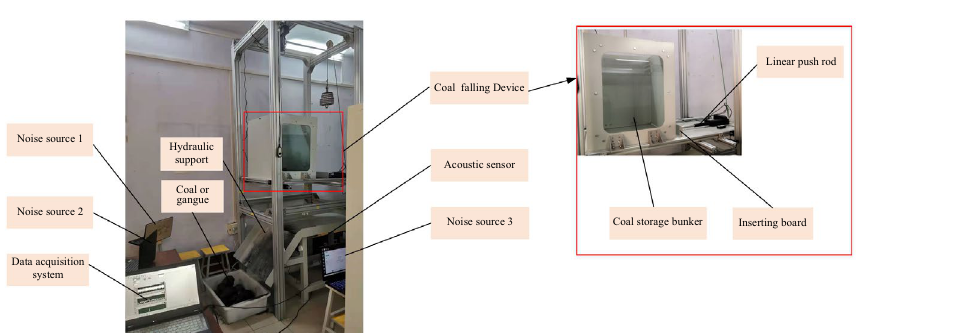
Figure 4. Technical route for identifying coal gangue under top coal.